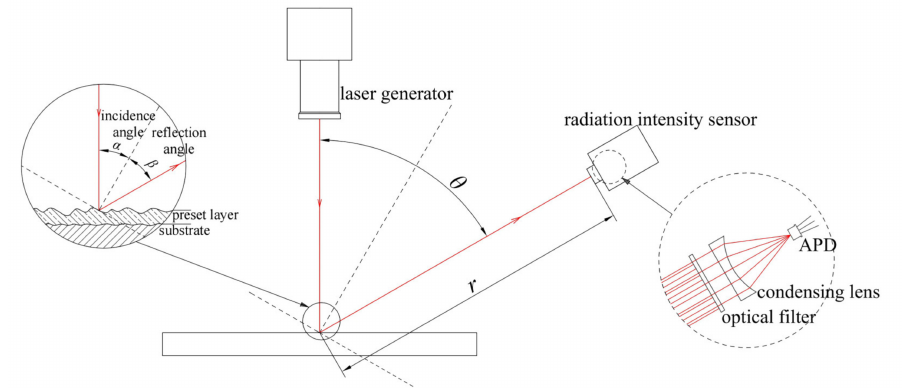
Figure 2. Path of reflected